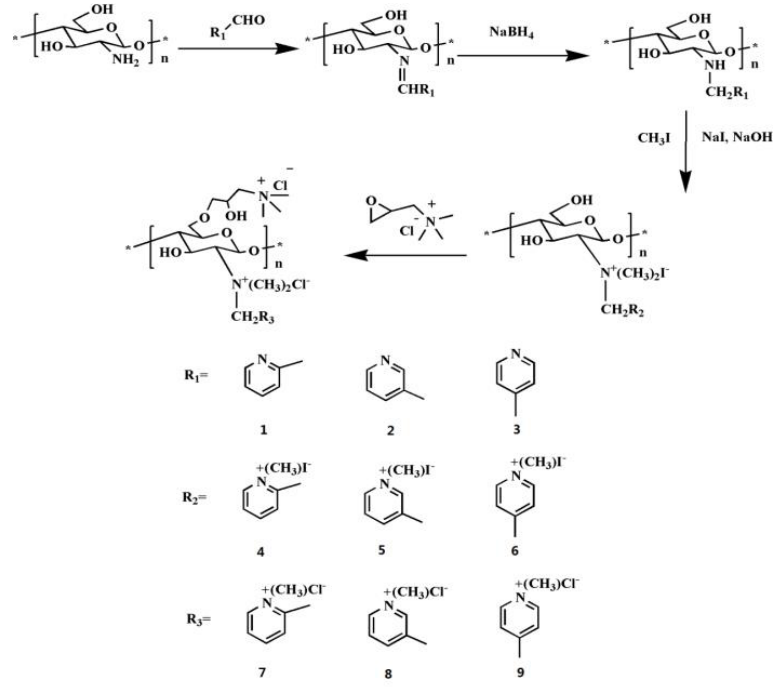
Scheme 1. The synthesis of triple quaternized chitosan derivatives. Table 1. The elemental analyses, yields, and the degrees of substitution of chitosan derivatives, and the degree of deacetylation of chitosan. Elemental Analyses (%) Degrees of Compounds Yields (%) Deacetylation (%) Substitution (%) C